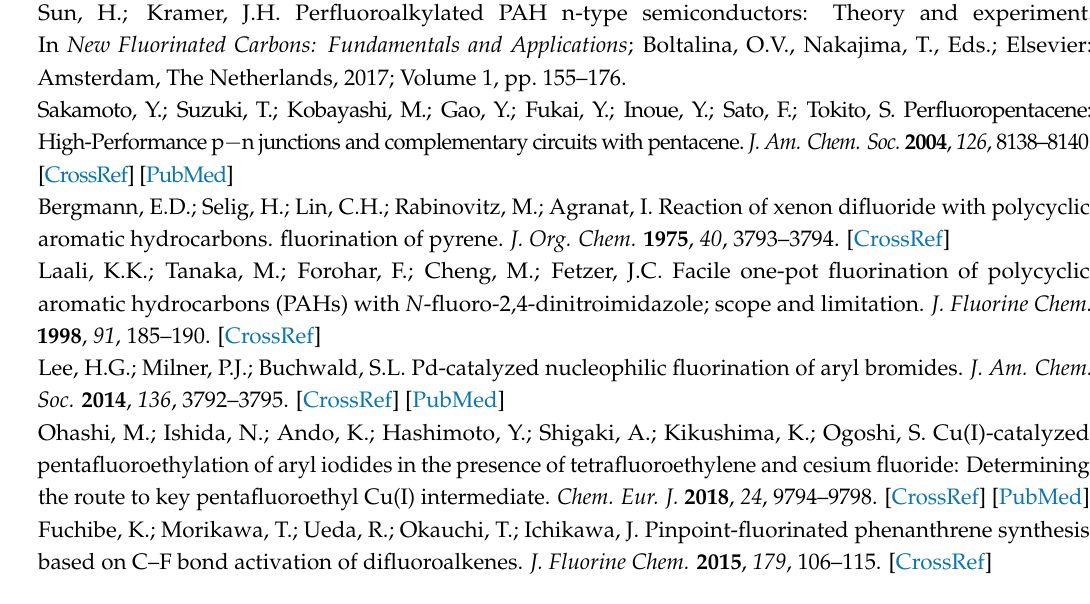
Figure S2. 19 F NMR spectrum of 2 in CDCl 3 . Figure S3. 13 C NMR spectrum of 2 in CDCl 3 . Figure S4. 1 H NMR spectrum of 3 in (CD 3 ) 2 CO. Figure S5. 19 F NMR spectrum of 3 in (CD 3 ) 2 CO. Figure S6. 13 C NMR spectrum of 3 in (CD 3 ) 2 CO. Figure S7. 1 H NMR spectrum of 4a in CDCl 3 . Figure S8. 19 F NMR spectrum of 4a in CDCl 3 . Figure S9. 1 H NMR spectrum of 4b in CDCl 3 . Figure S10. 19 F NMR spectrum of 4b in CDCl 3 . Figure S11. 1 H NMR spectrum of the first sublimate after sublimation of the crude product in CDCl 3 . Figure S12. UV-vis (A) and photoluminescence (B) spectra of 3 in CHCl 3 . Figure S13. Molecular structures of 3 . Figure S14. Molecular structures of 4a . Figure S15. Molecular structure of 4b . Table S1. Excited states and oscillator strengths of (a) dibenzoanthracene 4a and (b). benzoperylene 4b , calculated at B3LYP/6-611G(d) level. Table S2. Cartesian coordinates of the optimized geometry of 4a (in Å). Table S3. Cartesian coordinates of the optimized geometry of 4a-H* (in Å). Table S4. Cartesian coordinates of the optimized geometry of 4b (in Å). Table S5. Cartesian coordinates of the optimized geometry of 4b-H* (in